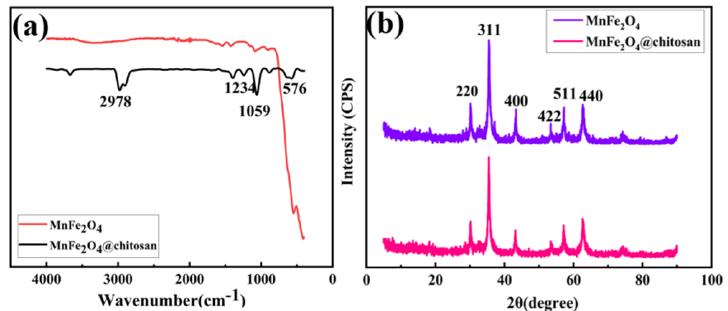
Figure 5. FT-IR spectra ( a ) and XRD ( b ) of naked MnFe 2 O 4 and MnFe 2 O 4